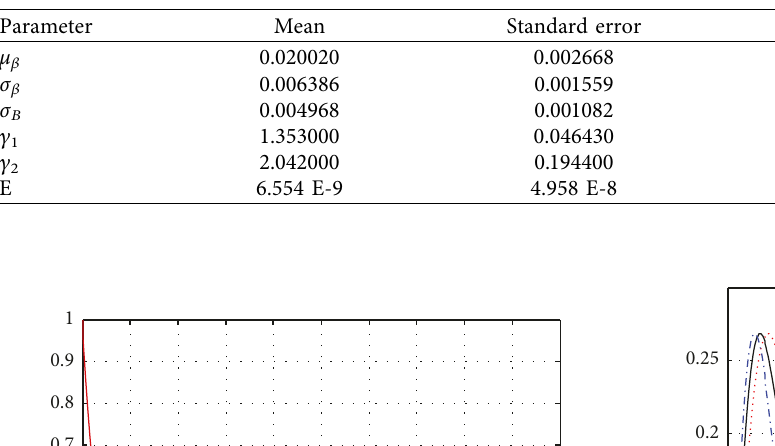
Table 3: Estimation results of the unknown parameters.